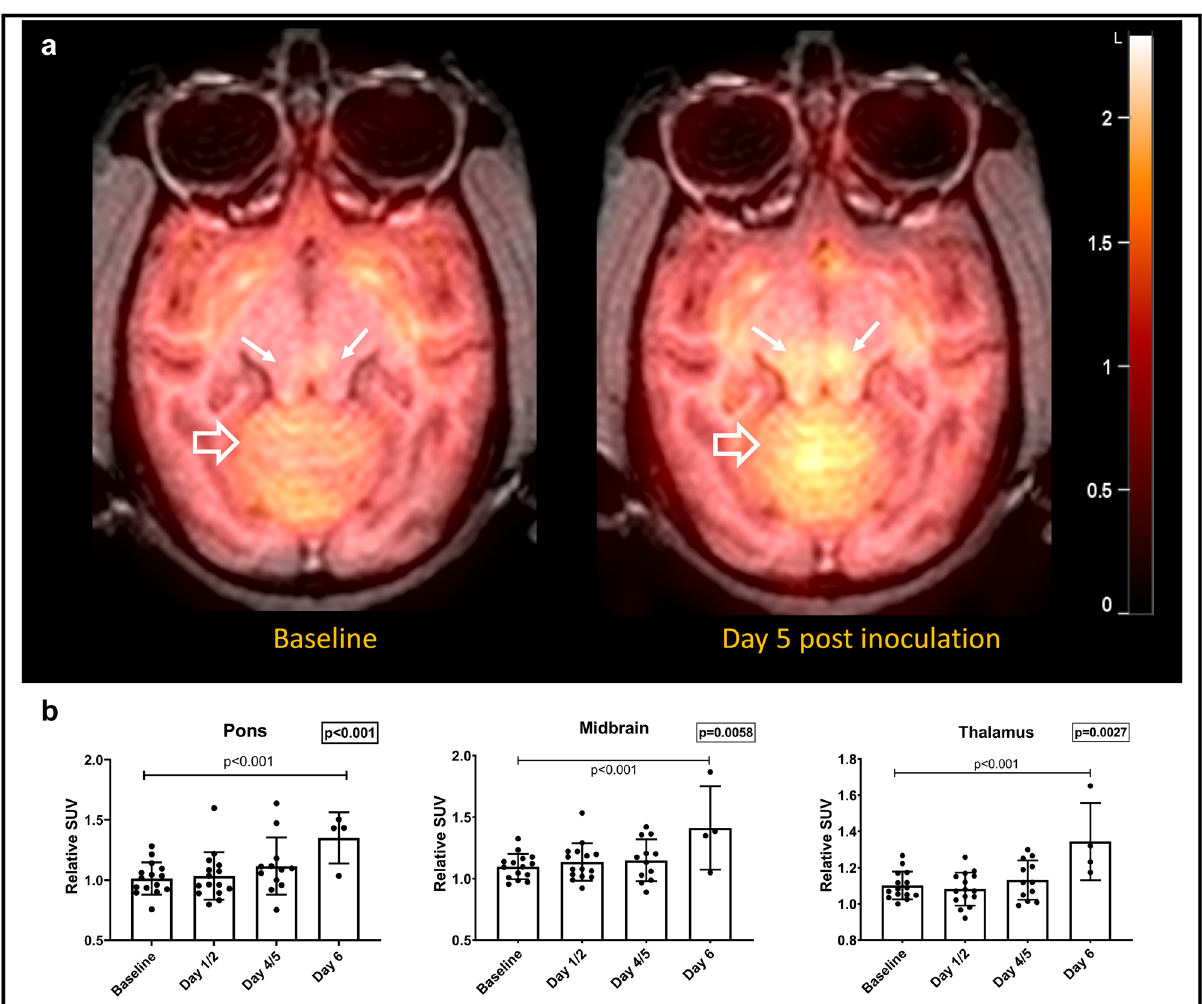
Fig. 3 Longitudinal FDG PET changes in infected monkeys. a Parametric relative SUV maps from a representative EBOV-infected animal showing increased uptake in the brainstem (solid white arrows) and cerebellum (open white arrows) on Day 5 post inoculation compared to baseline. b Signi fi cant increases in relative FDG uptake are seen in the thalamus, midbrain and pons over the course of disease ( n = 15 animals, Linear mixed effect model, S-plus 8.2, p = 0.0027, 0.0059 and 0.0007, respectively). Data are presented as mean values + / − SEM. Source data are provided as a Source Data fi